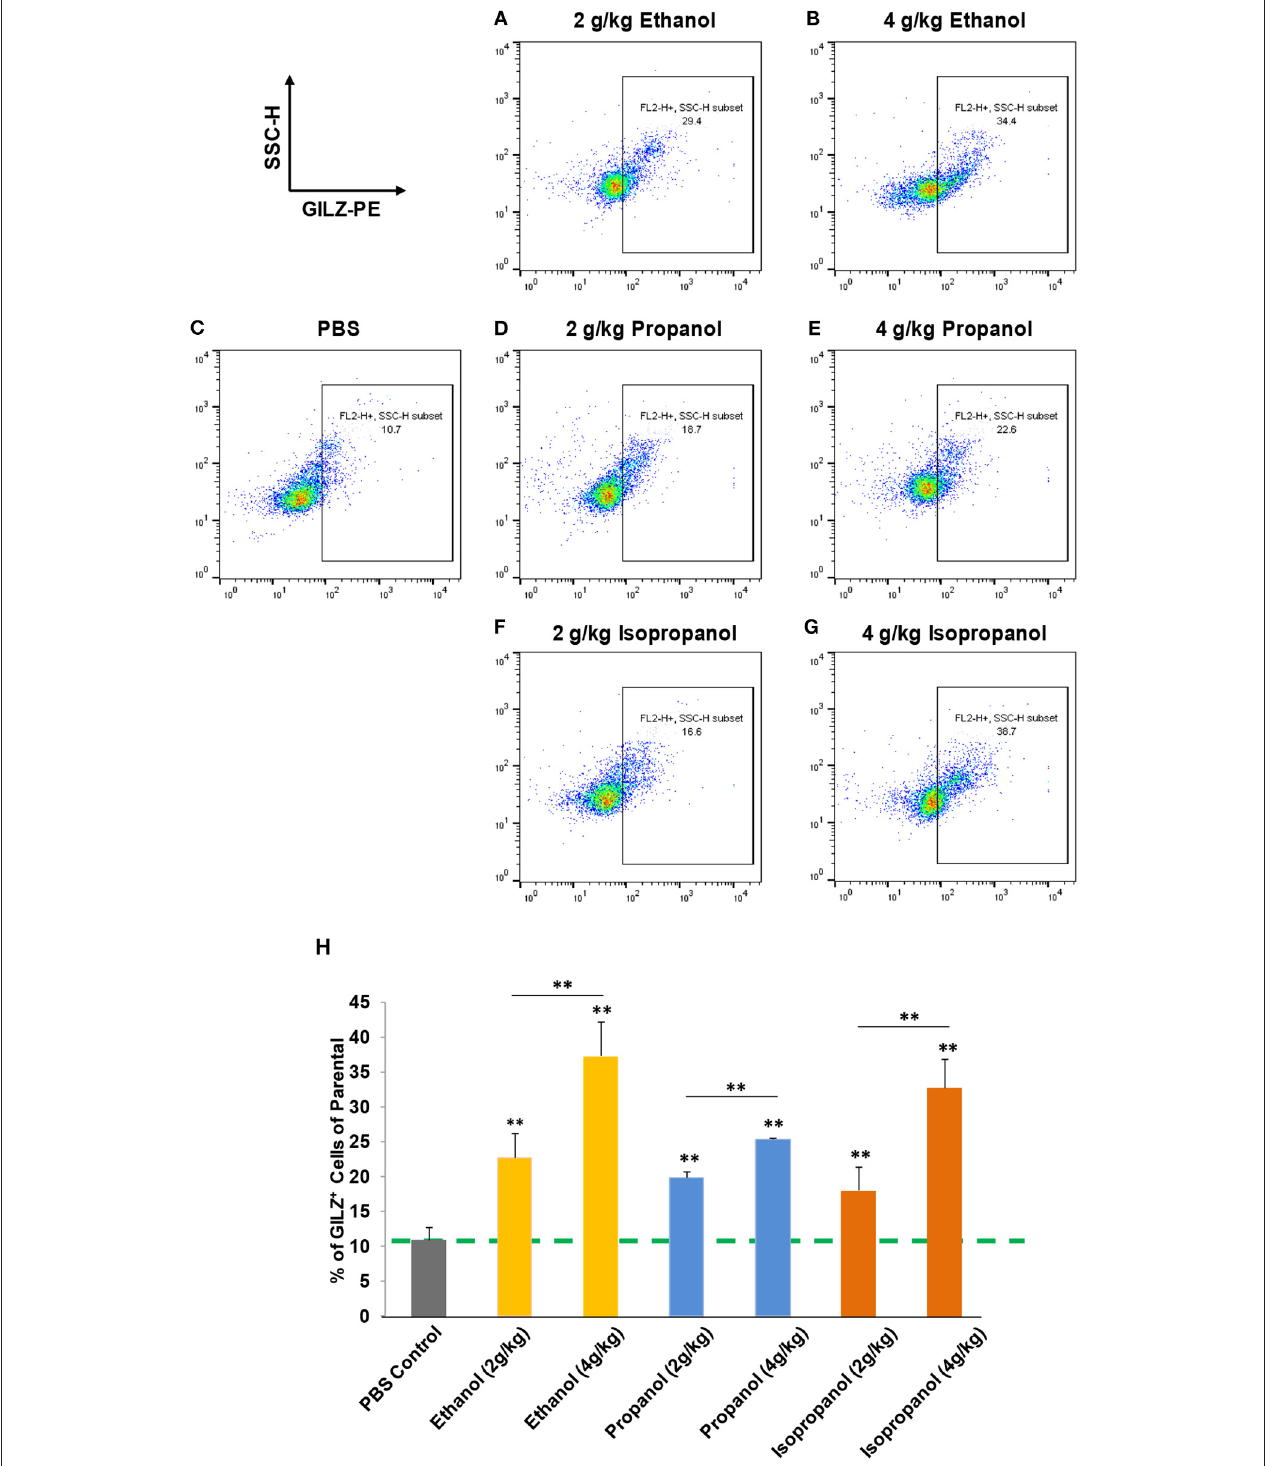
FIGURE 3 | Short-chain alcohols enhance GILZ gene expression in vivo . (A–G) Dot plot of flow cytometry. Mice were administered (i.p.) with 0, 2, or 4 g/kg of ethanol, propanol, or isopropanol. After 24h, peripheral blood from each animal was collected, and white blood cells (WBCs) were isolated and subjected to immunostaining for GILZ, followed by flow cytometry. Representative data from each treatment are shown. (H) Statistical data. GILZ expression from each condition was compared to that of the PBS control (dashed line). Data are expressed by percent of GILZ-positive cells in each sample. Asterisks denote statistically significant difference in each comparison by Student’s t -test ( p < 0.01, n = 4 per